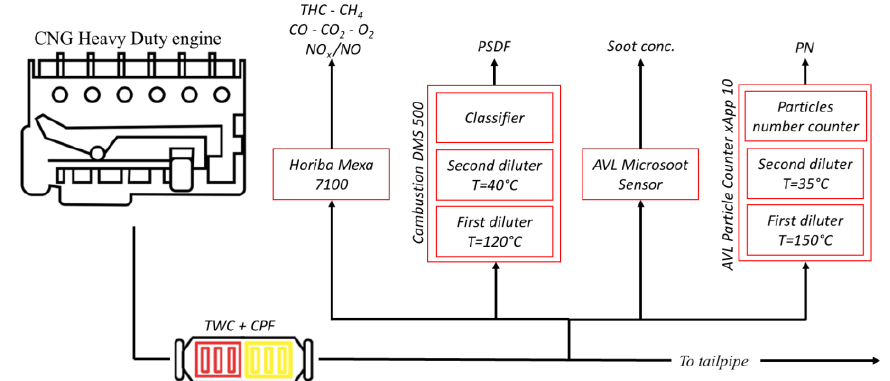
Figure 1. Engine test bench the experimental layout.